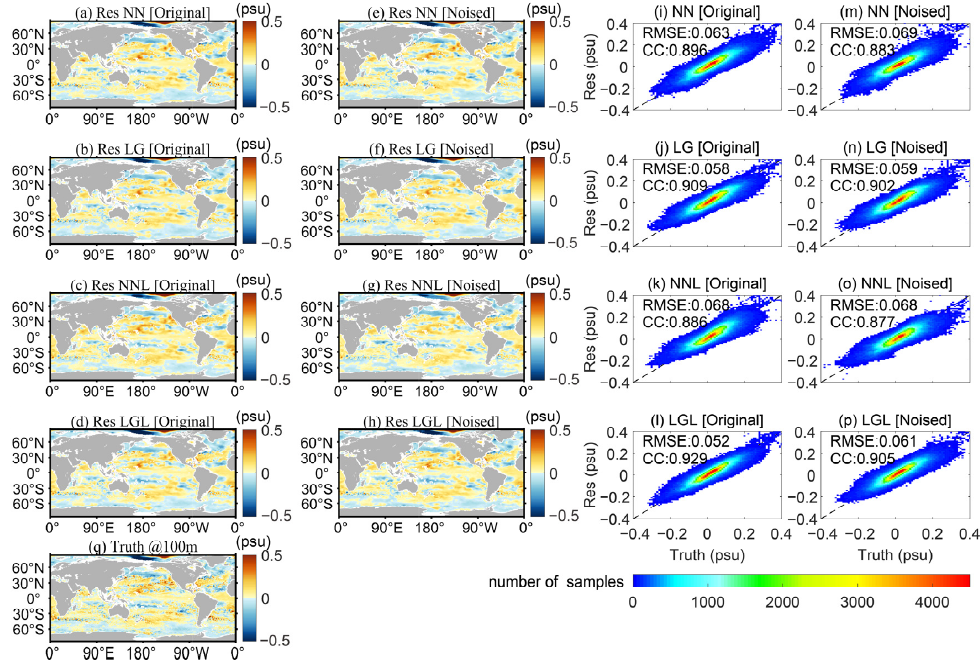
Figure 4. Spatial distribution of reconstructed data and density scatter plots of reconstructed vs. truth values for the four experiments at 100 m depth in January 2016. ( a – d ) and ( i – l ) Reconstruction based on the original synthetic dataset. ( e – h ) and ( m – p ) Reconstruction based on the noised synthetic dataset. ( q ) Truth value of CNRM-CM6-1-HR. The color-coded dots represent the number of samples.